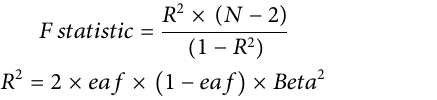
Frontiers in Genetics |